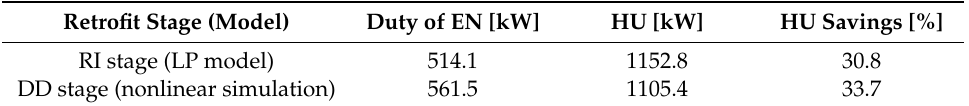
Table 4. The heat duty results of exchanger EN obtained from the Retrofit Identification (RI) stage and Detail Design (DD) stage.